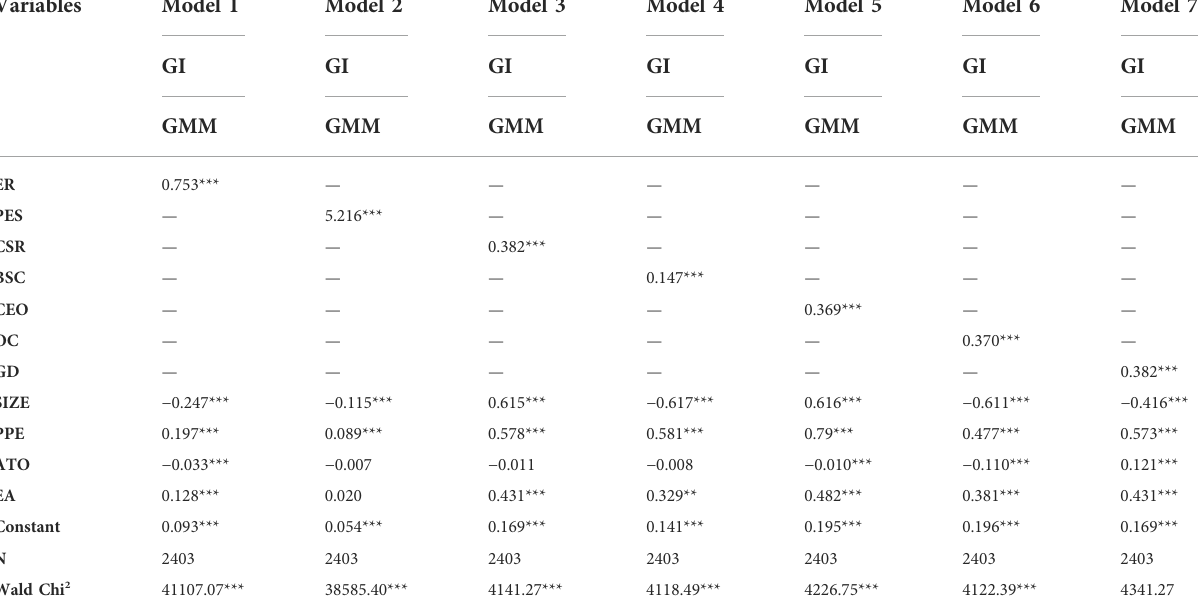
TABLE 2 Results of link between Business Environmental Strategies and Green Innovation, Corporate Management and Green